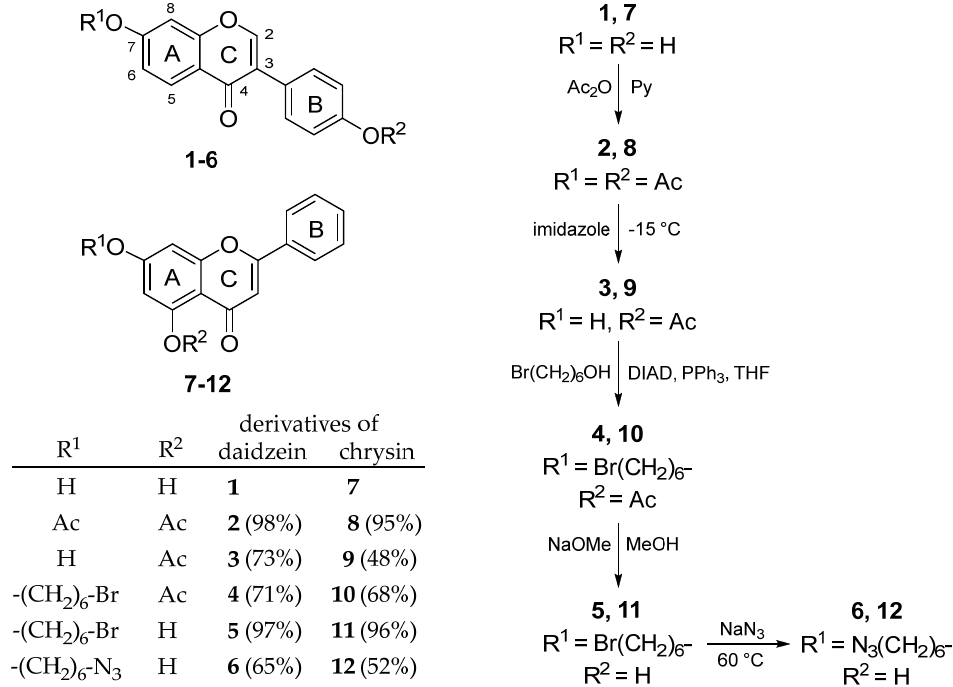
Figure 1. Synthesis of 7-azidohexyl ethers of daidzein and chrysin.